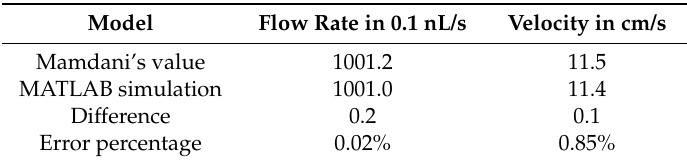
Table 2. Simulated results with Mamdani’s results.